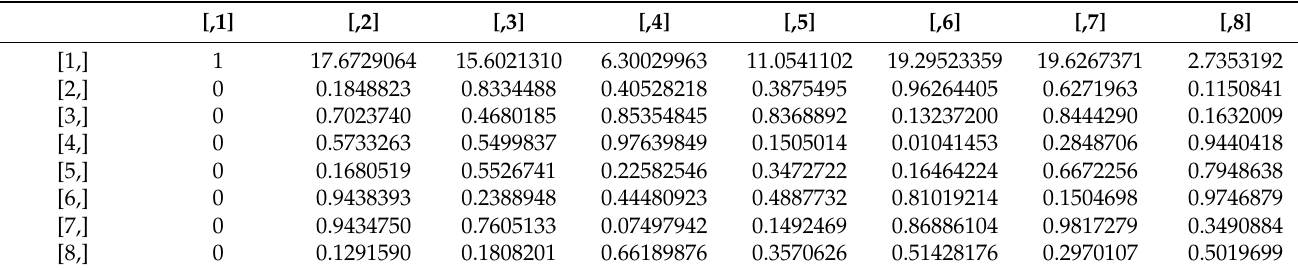
Table 4. Matrix D.